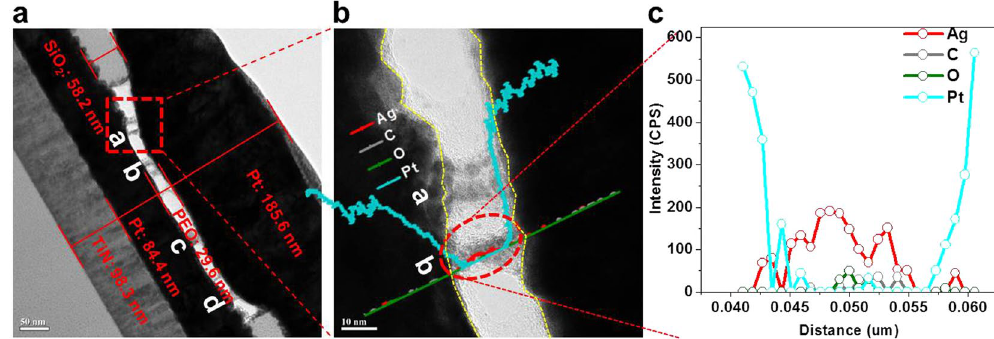
Figure 3. Morphology and chemical composition of Ag filaments in PEO polymer electrolyte. ( a ) cross- sectional TEM image of the CBRAM cell fabricated with 30 wt% Ag-doped PEO polymer electrolyte, ( b ) calibration between morphology and chemical compositional profile of Ag filament, and ( c ) chemical compositional depth profile of Ag filament. ( V set ), reset voltage ( V reset ), and memory margin ( I on /I off